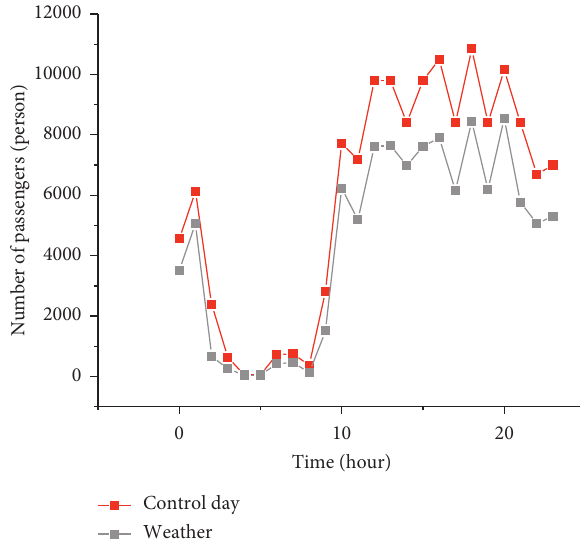
Figure 9: Comparison of the passenger number on control day and weather.